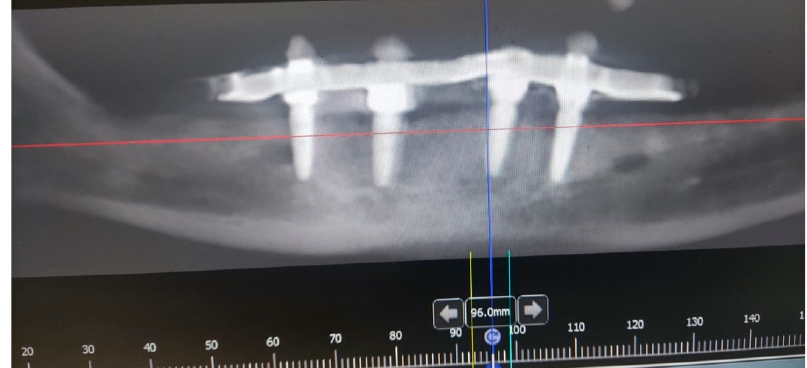
Figure 1. Clinical appearance of the mass during first visit.